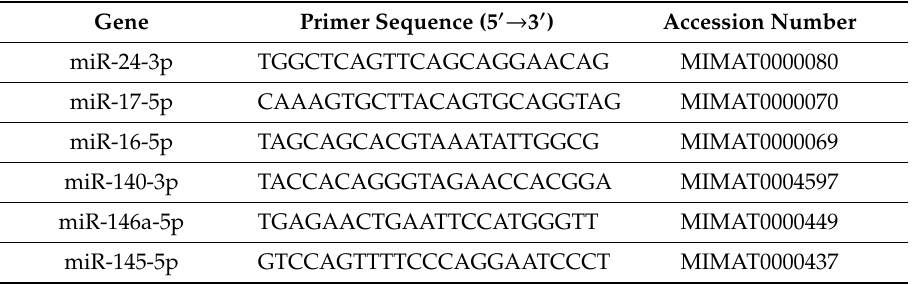
Table 2. Sequences of the primers used in the qPCR for the miRNA expression analysis. Gene Primer Sequence (5 (cid:48) → 3 (cid:48) ) Accession